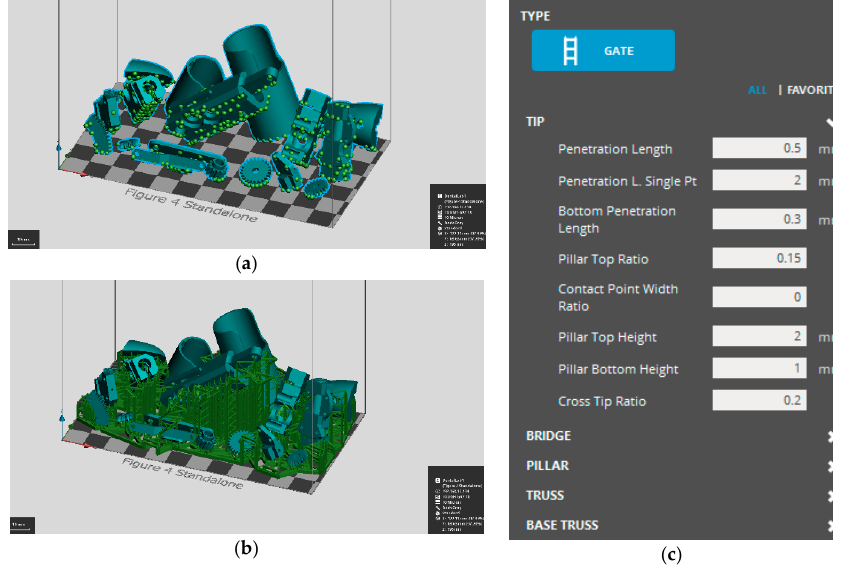
Figure 21. Optimization and creation of the support structure. ( a ) Support points generated by the software, ( b ) support pillars based on the generated points, ( c ) support settings. Once the optimization and virtual build procedure ended, the printing process started. The result of the 3D printing can be seen in the images below (Figure 22).